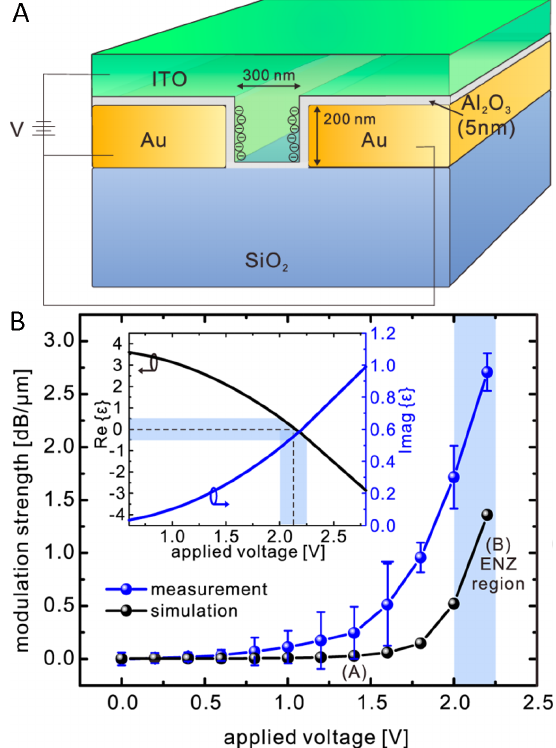
Figure 18: (A) TCO modulator based on a plasmonic slot waveguide. (B) High modulation strength is achieved because of the good over- lap of the propagating plasmonic mode and the ITO layer. Copyright (2014), American Chemical Society, from Ref. [143], with permission of the authors. ITO: Indium tin oxide; TCO: Transparent conducting